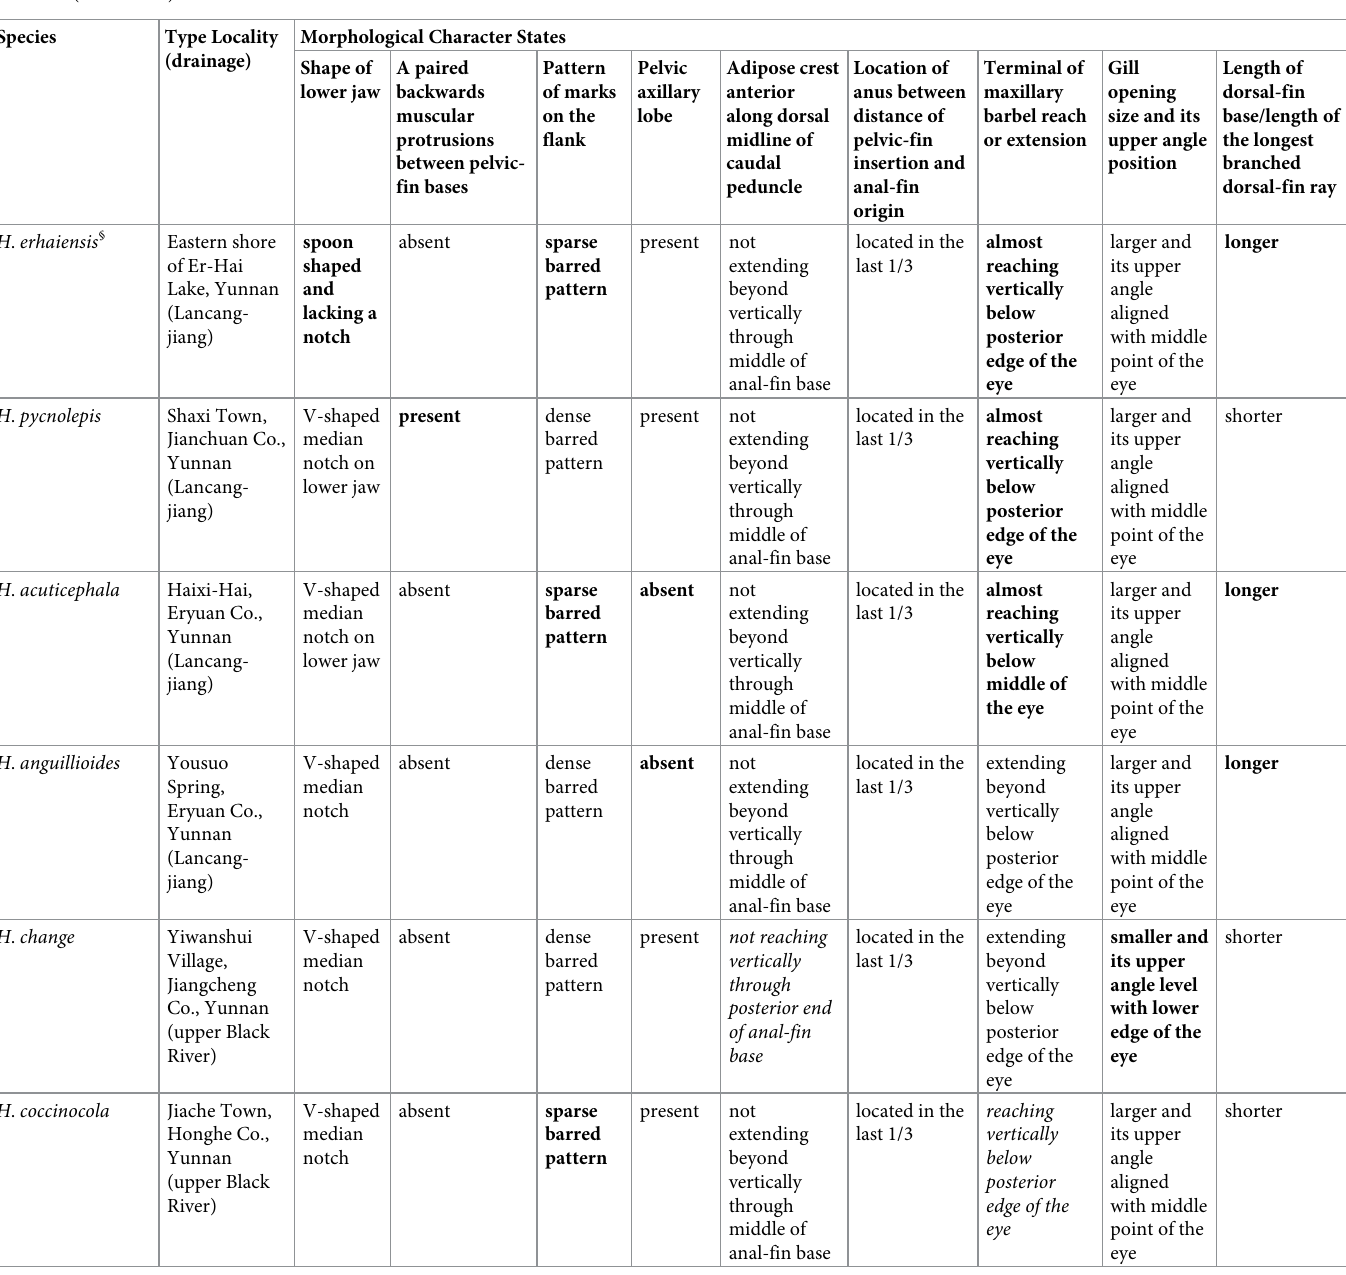
Systematic comparison of the specimens from the Nu-jiang, Lancang-jiang, and Lixiang-jiang drainages indicates that there are 13 valid species, including three undescribed new species. All 13 species share the following combination of character states: densely scaled body except head; lateral line complete; and a short adipose crest along the dorsal midline of the